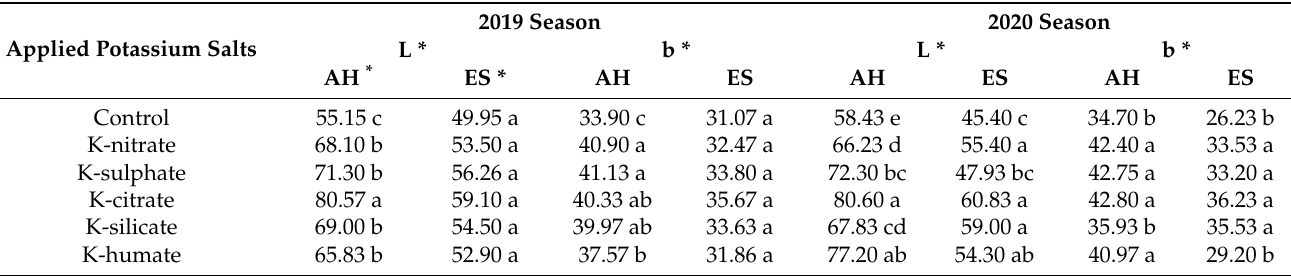
Table 2. Effect of diverse potassium sources as foliar application on color values represented in L and b degree for ‘Canino’ apricot fruits after harvest and at end of the storage in the 2019 and 2020 seasons.